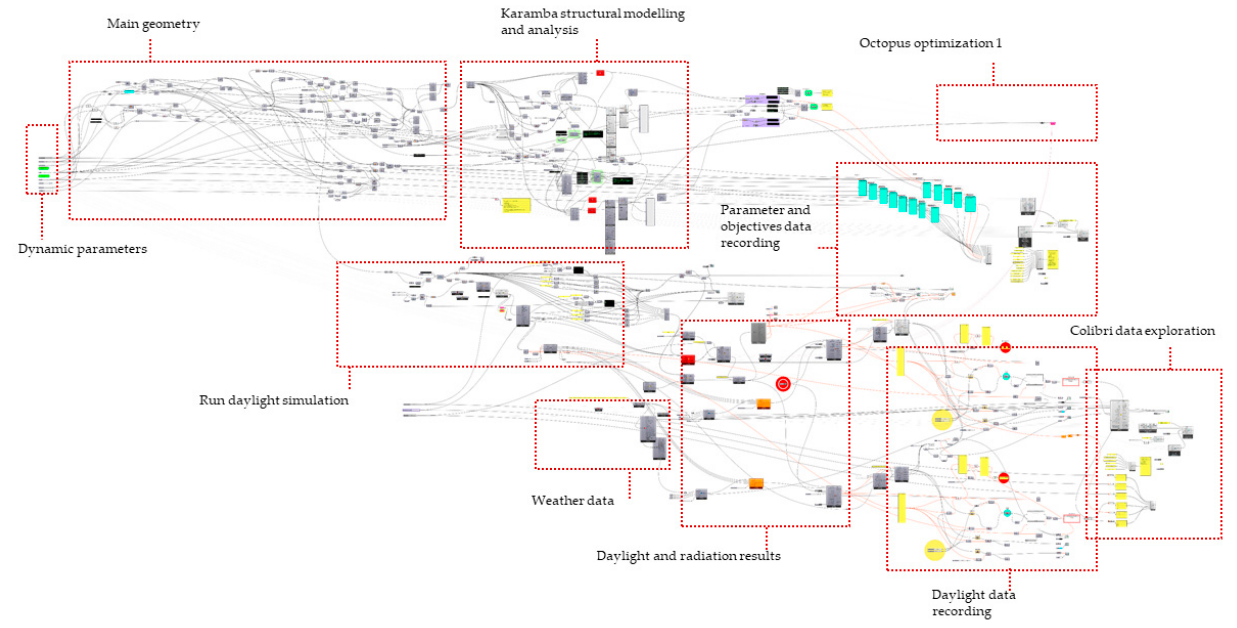
Figure 6. Parametric definition clustering of the entire system .